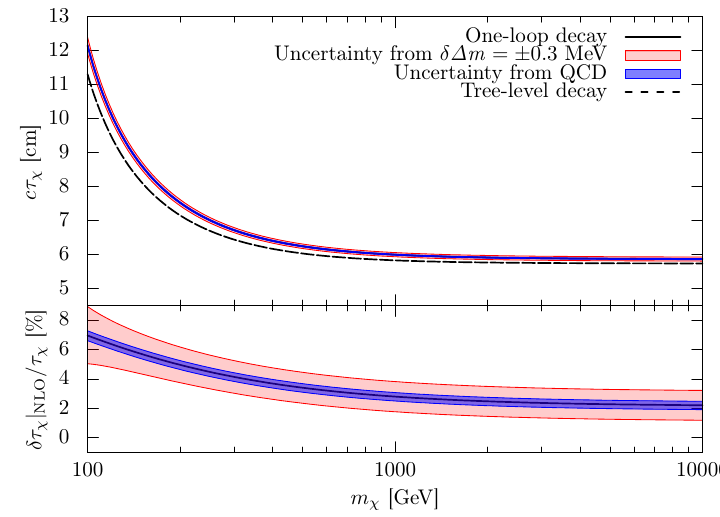
Figure 3 . The Wino decay length as a function of the Wino mass m χ . We show the central value of our estimation in black solid lines. We also show the tree-level decay length in a black dashed line. The blue bands show the uncertainty of our one-loop estimation from the QCD dynamics. The red bands show the uncertainty from the three-loop correction to the Wino mass difference, δ ∆ m = ± 0 . 3 MeV in ref. [14]. Here we define δτ χ | NLO ≡ τ χ | NLO − τ χ | LO